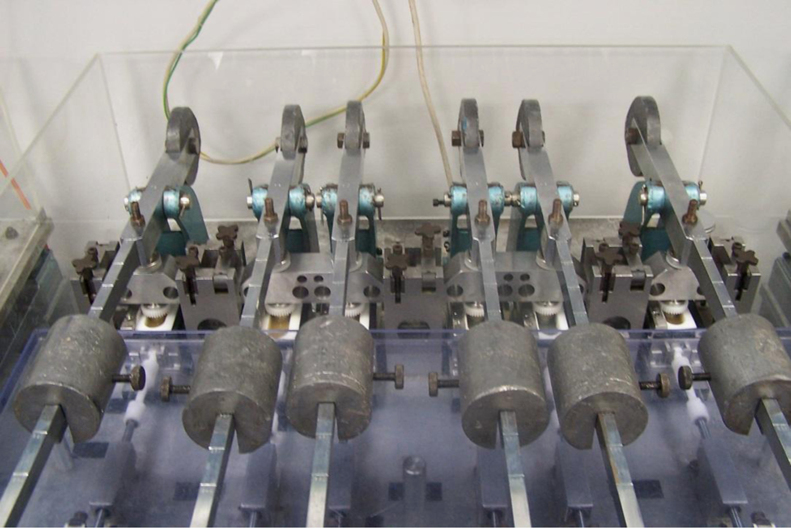
Pin on plate rig.